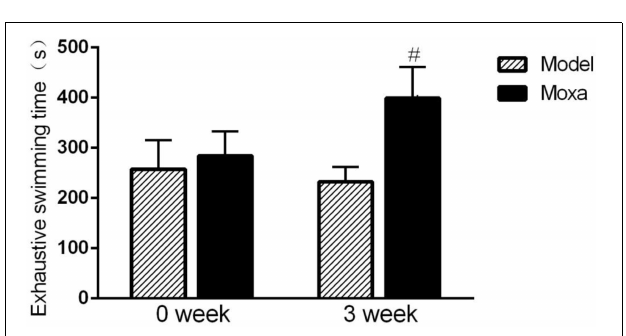
FIGURE 2 | The chronic exhaustive swimming procedure lasted 3 weeks. The behavioral test was performed on week 0 and week 3 (day 1 and day 21, respectively). Exhaustive swimming in the following groups ( N = 8 per group): Model, Moxibustion (Moxa). Data are means ± SEM. # P < 0.05 as compared with the Model group.